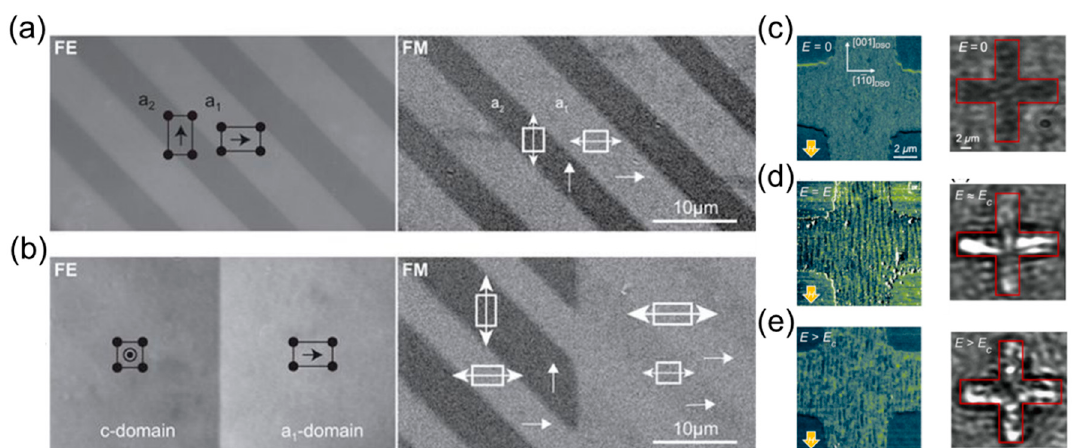
Figure 10. ( a ) Ferroelectric (FE) and ferromagnetic (FM) microstructure after CoFe film growth on BTO and ( b ) the application of an out-of-plane electric field of 10kV / cm imaged using optical polarization microscopy techniques. Reprinted with permission from [70], ( c–e ) ( right ) The spatially resolved MFM scans show the magnetic domain structure of CoFe after the application of the indicated electric field. MFM scans are recorded in the presence of an in-plane magnetic field of µ 0 H = 50 mT along [001] DSO , ( left ) spatially resolved SHG images of buried ferroelectric BFO domains after application of indicated electric fields. The red contour line highlights the area of the cross-shaped CoFe electrode. Reprinted with permission from [93], copyright the American Physical Society, 2018.